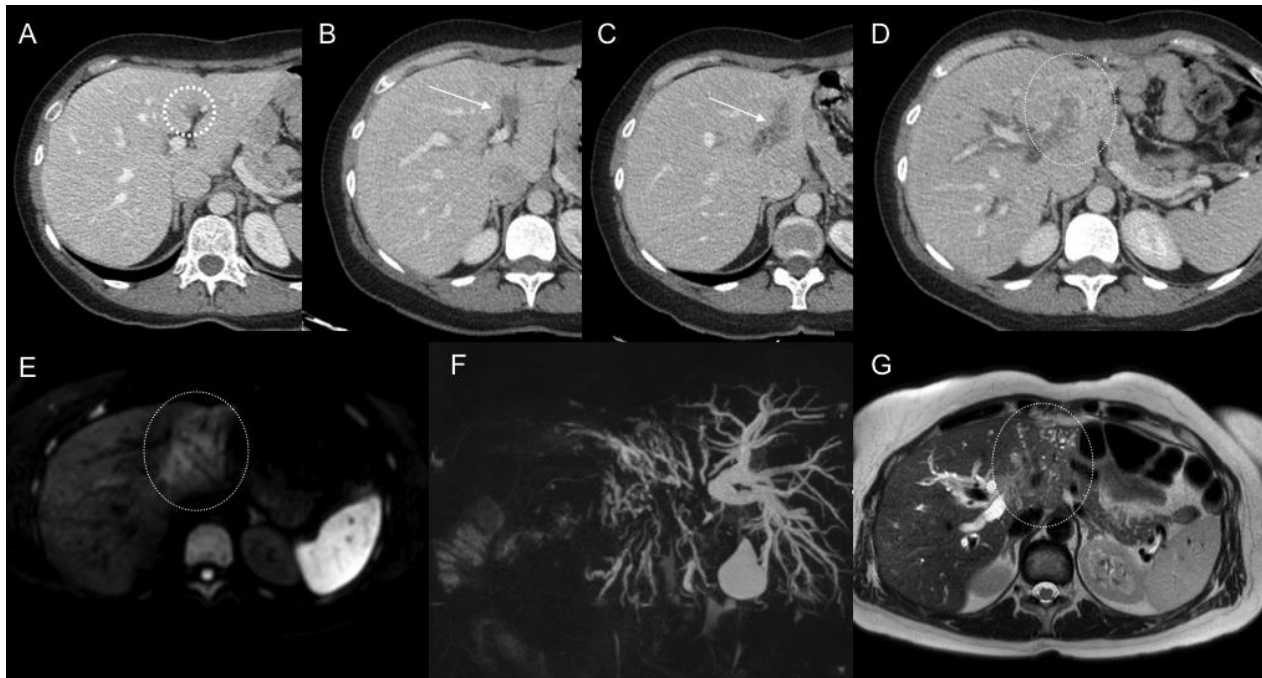
Figure 1. Focal soft tissue lesion in the deep part of the falciform ligament (circle), retrospectively identified in the first CT scan post-surgery ( A ) of a patient who underwent surgery because of gastric adenocarcinoma with positive peritoneal lavage. Progressive increase in size during the follow-up CT scans ( B , C ) involving the left portal vein and being mis-diagnosed as portal vein thrombosis (arrows). Further follow-up showed evidence a soft tissue infiltrating mass (oval) in left hepatic lobe ( D ) and DWI-b800 ( E ) and T2WI ( G ) MR images, with spread along periportal spaces and conditioning biliary obstruction as MRCP ( F ) shows.